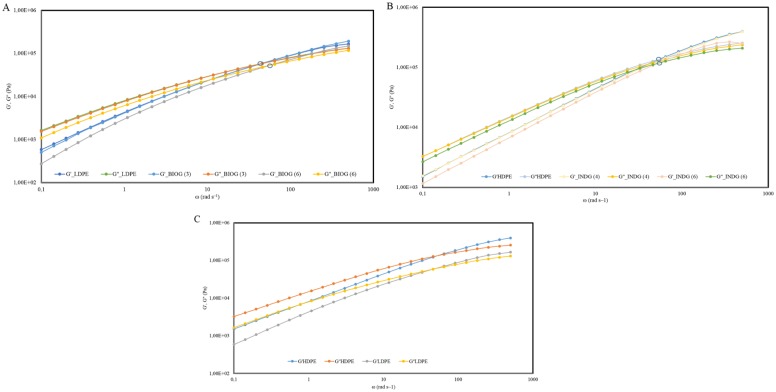
Rheological analysis.A) Master curves of storage (G΄) and loss (G΄΄) moduli as a function of frequency corresponding to the BIOG treatments of phase II, B) Master curves of storage (G΄) and loss (G΄΄) moduli as a function of frequency corresponding to the INDG treatments of phase II and C) Master curves of storage (G΄) and loss (G΄΄) moduli as a function of frequency corresponding to the weathered plastics.